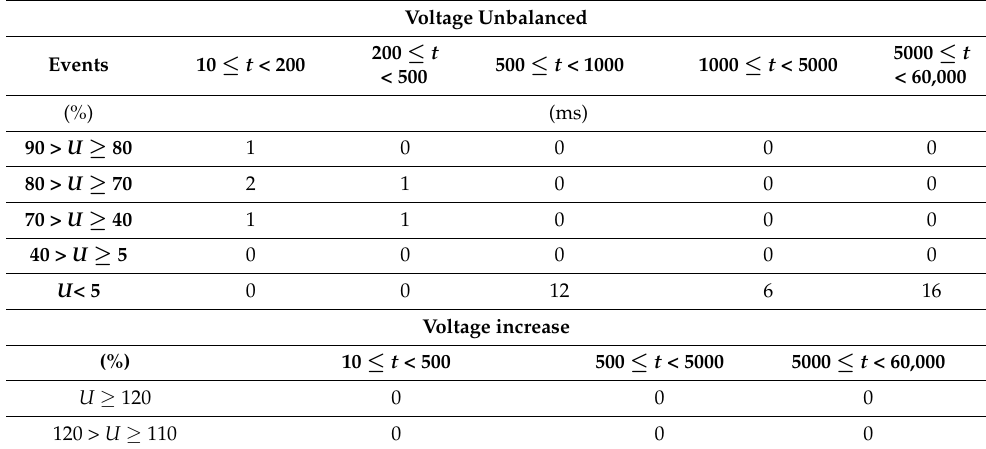
Table 2. Division of registered events in the supply voltage due to their duration.